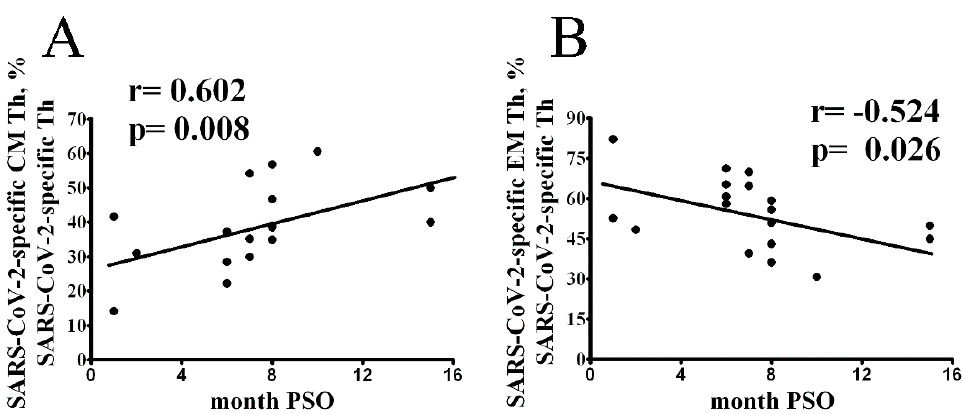
Figure 2. Longitudinal analysis of SARS-CoV-2-specific Th cell frequency and differentiation status. Scatter plots showing the relationship between the frequency of SARS-CoV-2 CM ( A ) and EM ( B ) Th cells within total SARS-CoV-2-specific Th cells. A statistical analysis was performed using the Spearman’s rank-order correlation ( n = 19).